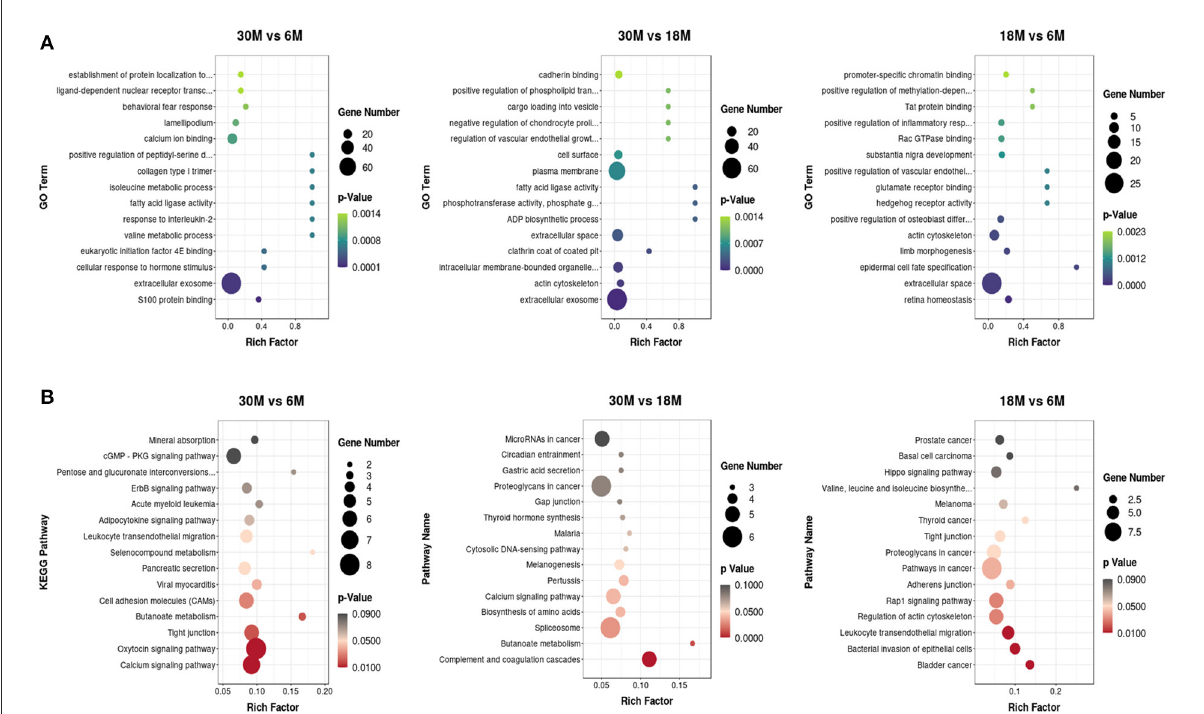
FIGURE5 The top 15 GO and KEGG terms for DE miRNAs from the three comparison groups. (A) GO analysis; (B) KEGG